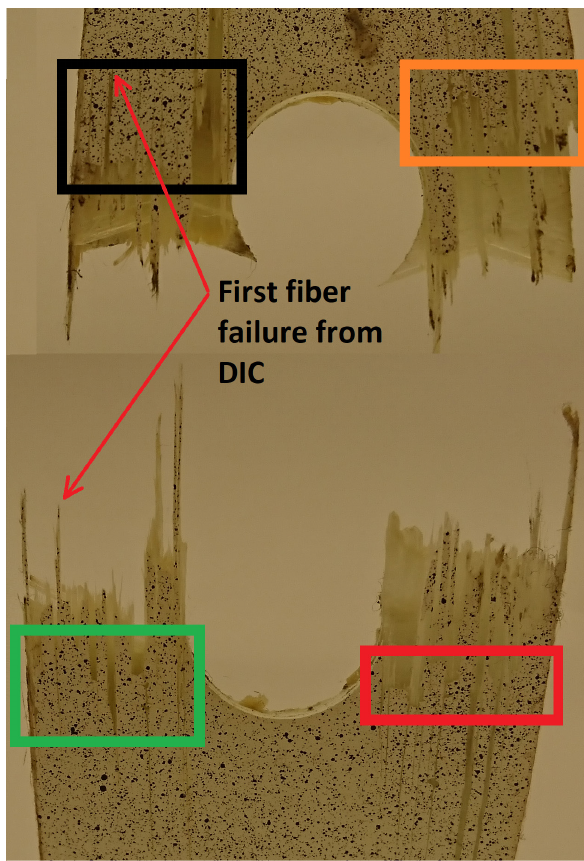
Figure 14: Image of the failed specimen with fiber failure origins outlined in colored squares. The final fracture line runs along both upper and lower side of the specimen and the fiber failures “jump” across the center of the specimen. First fiber failure from the DIC contour plot in Figure 8 is